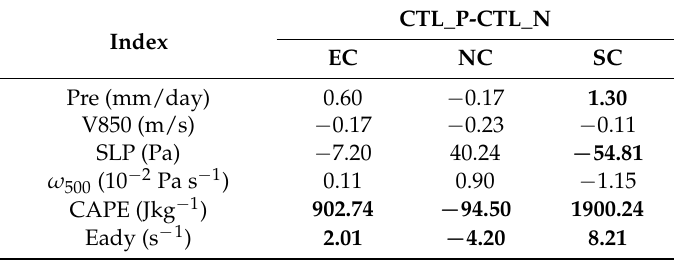
Table 2. Climate response of EASM-relevant quantities to different PDO phases. The differences were compared by the experiment between CTL_P and CTL_N which is related to SST of positive and negative phase. The quantities include precipitation (Pre), meridional wind of 850 hPa (V850), sea level pressure (SLP), vertical velocity on 500 hPa ( ω 500 ), convective available potential energy (CAPE), and the Eady growth rate (Eady). Their differences between the experiments were averaged over Eastern China (EC, 20–45 ◦ N, 105–122 ◦ E), Northern China (NC,32.5–45 ◦ N, 105–122 ◦ E), and Southern China (20–32.5 ◦ N, 105–122 ◦ E). The numbers in boldface are statistically significant at the 10%